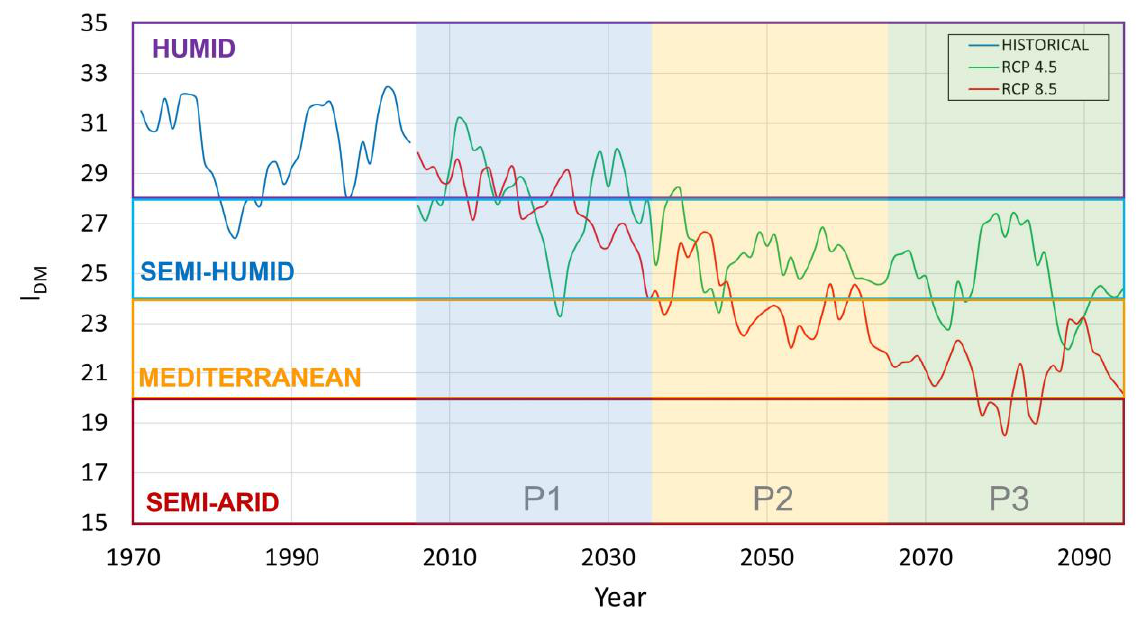
Figure 4. Temporal evolution of the De Martonne aridity index (I DM ) using 5-year moving averages during the historical period, blue line, and the near future (P1), 2006–2035, the mid-century (P2), 2036–2065, and the end of the century (P3), 2066–2095, under the RCP4.5, green line, and RCP8.5, red line, scenarios.